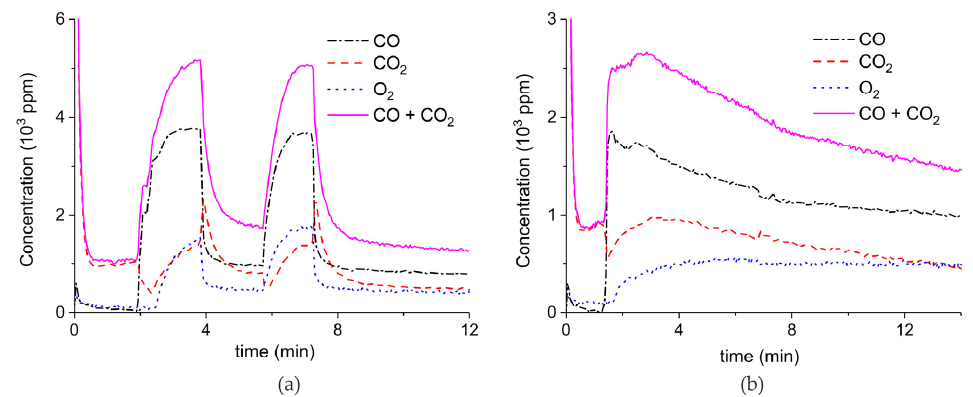
Figure A5. Concentration of the products of CaCO 3 decomposition (sample E) as function of time at 630 °C in pure argon and flow rate of 30 mL/min. Plasma power is 4.4, 1, 4.9, and 1 W ( a ) and 1.7 W ( b ). Plasma is turned on after 2 min and changed every 2 min (a) or after 1.5 min (b).